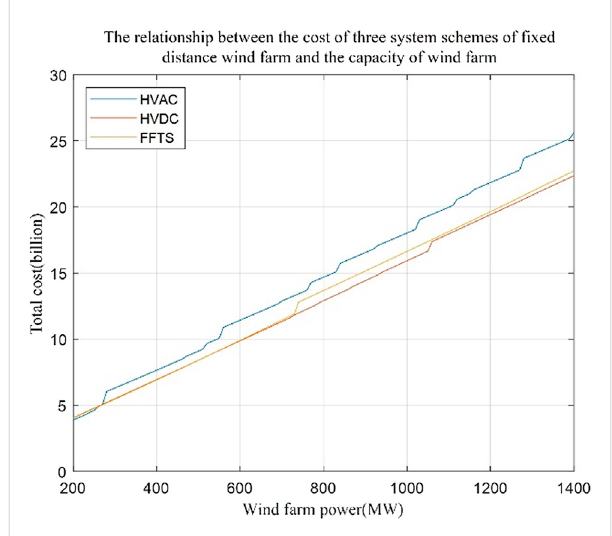
FIGURE 5 Comparison of cost transmission capacity curves of three schemes of 150 km wind